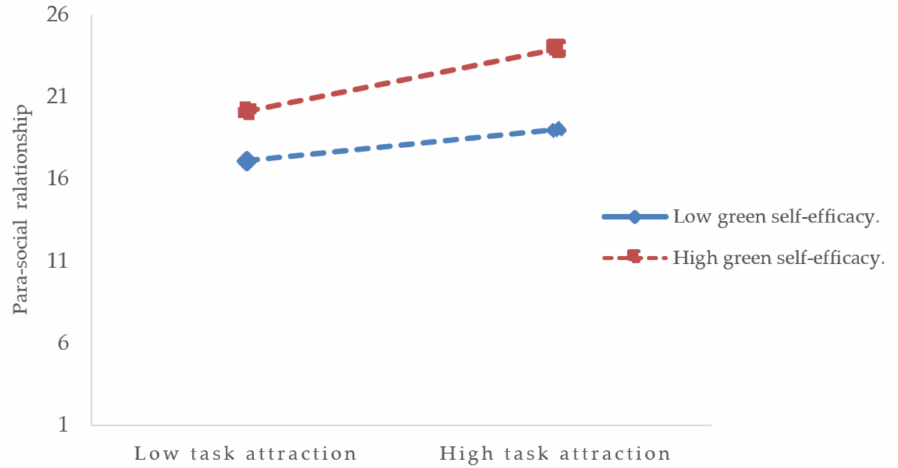
Figure 3. The moderating effect of green self-efficacy with task